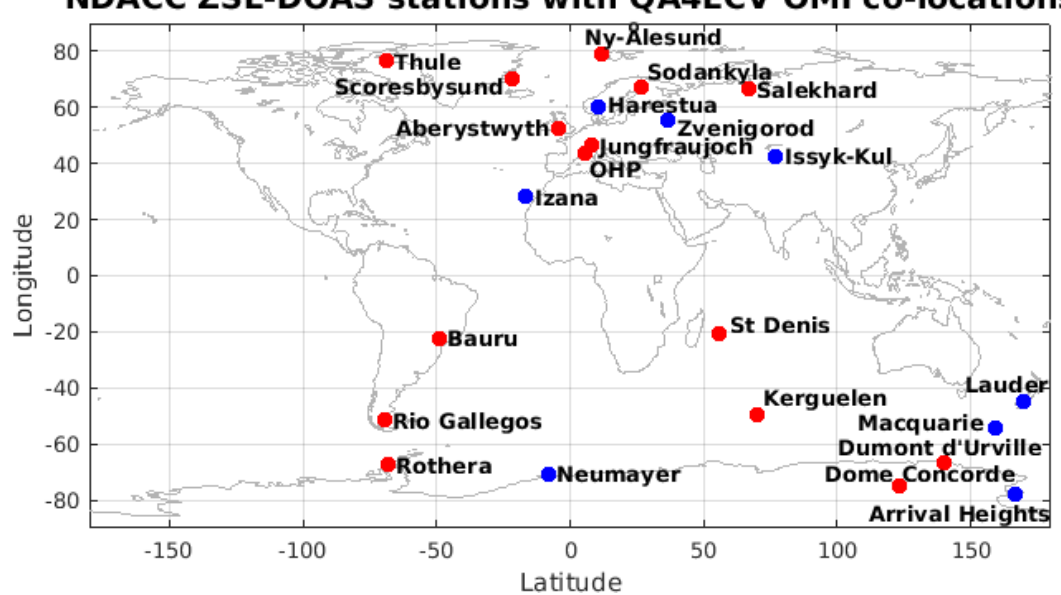
Figure 1. Global distribution of the ZSL-DOAS instruments used in this study. Red markers indicate SAOZ instruments, and blue markers indicate other NDACC ZSL-DOAS